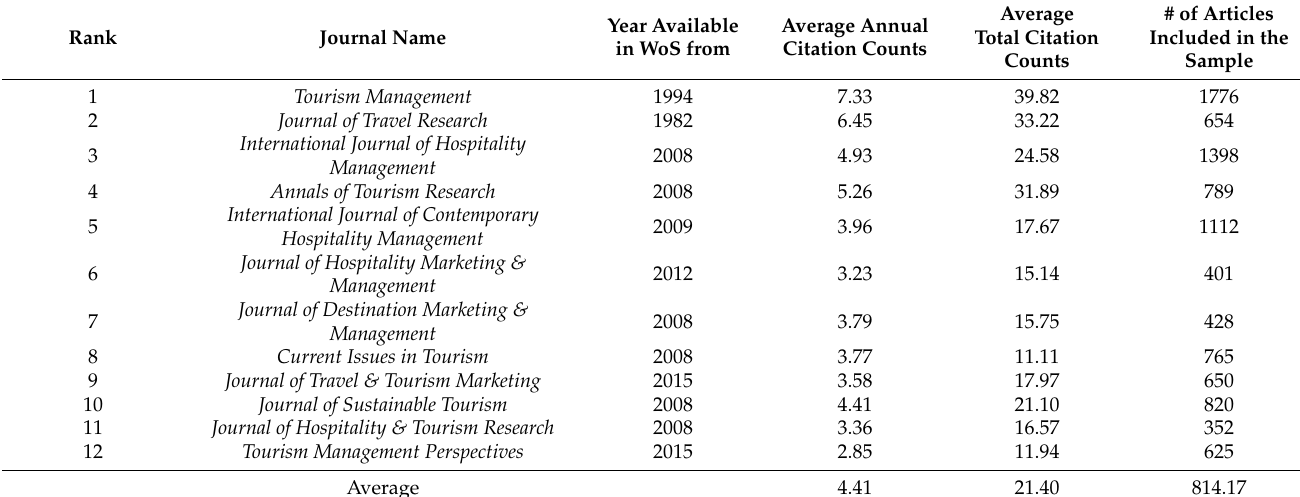
Table 1. List of journals and number of journal articles in the